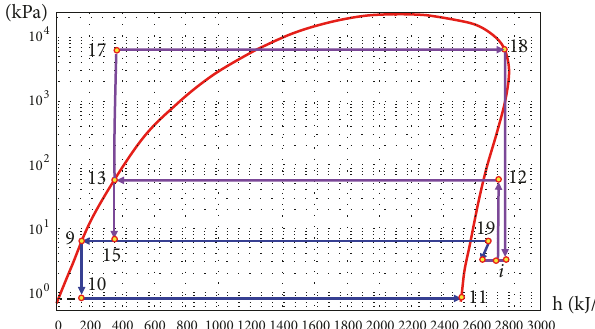
Figure 5: Chiller cycle representation in the water (𝑃 − ℎ)− diagram (𝑇 𝑆𝐺 ≈ 200 ∘ C ;𝑇 𝐺 = 85 ∘ C ; 𝑇 𝐸𝑉 = 4 ∘ C ; 𝑇 𝐶𝐷 = 37 ∘ C ) .